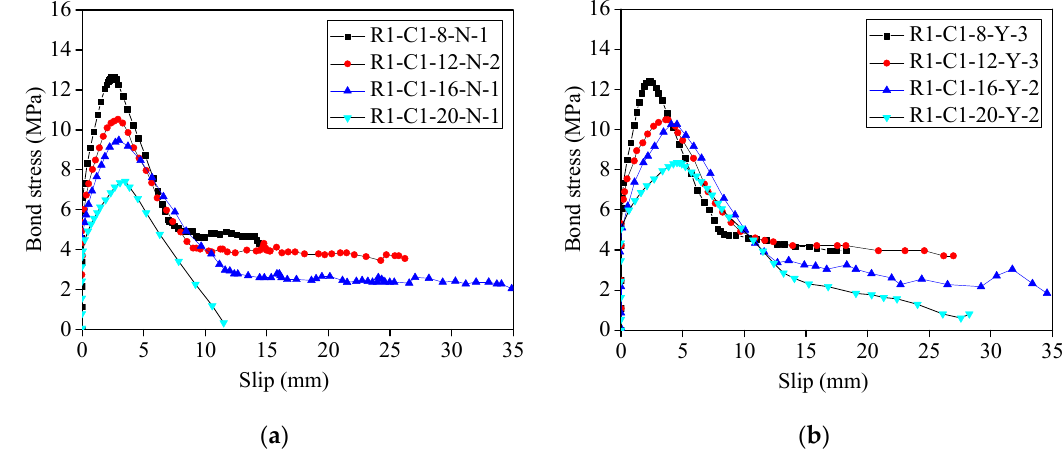
Figure 5. Representative τ - s curves for R1 bars for the ( a ) without and ( b ) with stirrups.